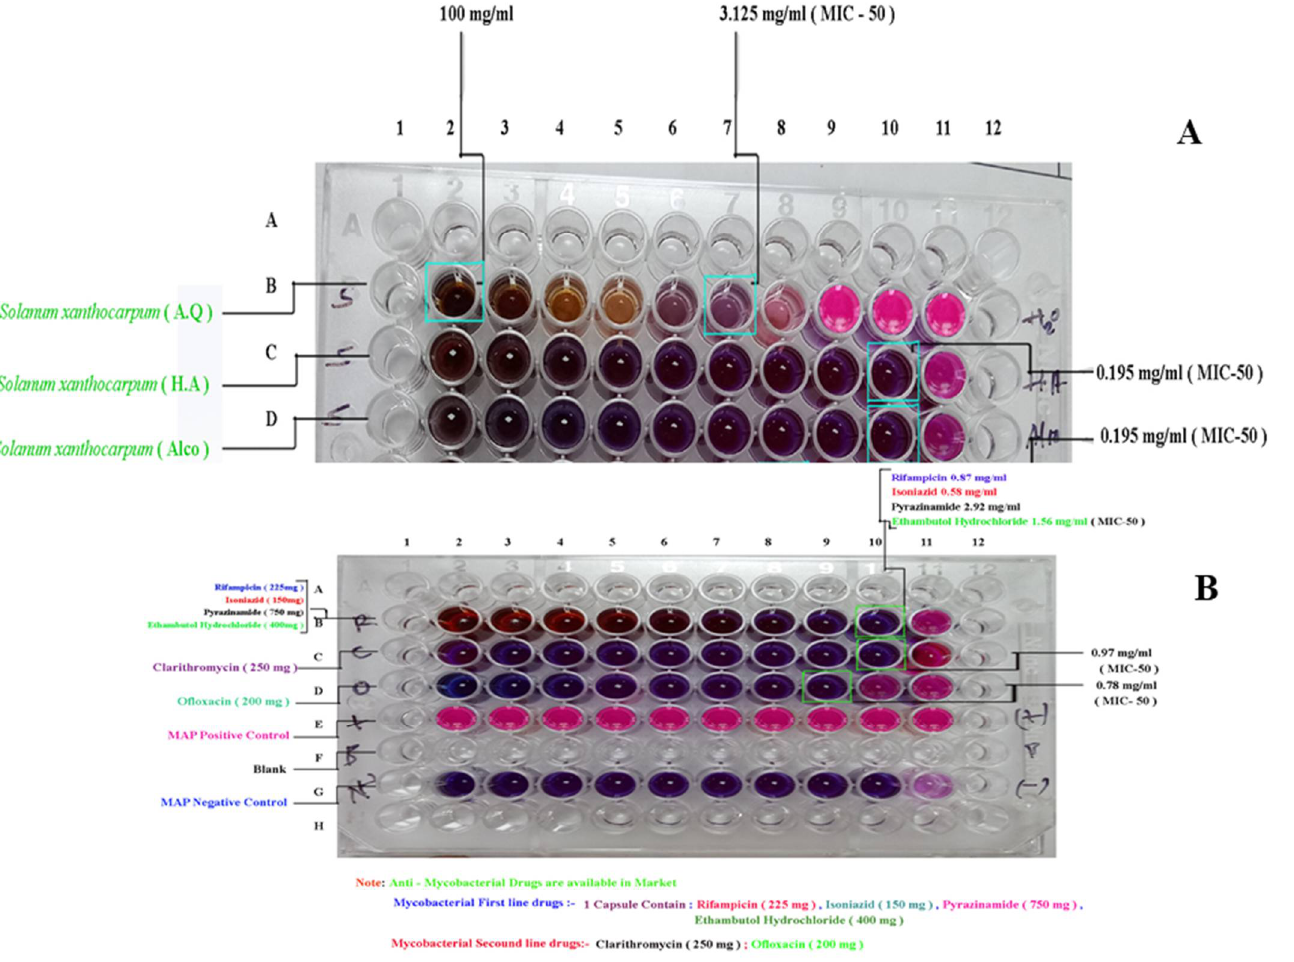
Figure 5. REMA assay. ( A ) In vitro activity of test extracts, i.e., A.Q (aqueous), H.A (hydro-alcoholic) and Alco (alcoholic) extracts of Solanum xanthocarpum Schrad. & Wendl. ( B ) In vitro activity of standard anti-mycobacterial first line drugs, i.e., Rifampicin (225 mg), Isoniazid (150 mg), Pyrazinamide (750 mg), Ethambutol hydrochloride (400 mg) and second line drugs, i.e., Clarithromycin (250 mg), Ofloxacin (200 mg).